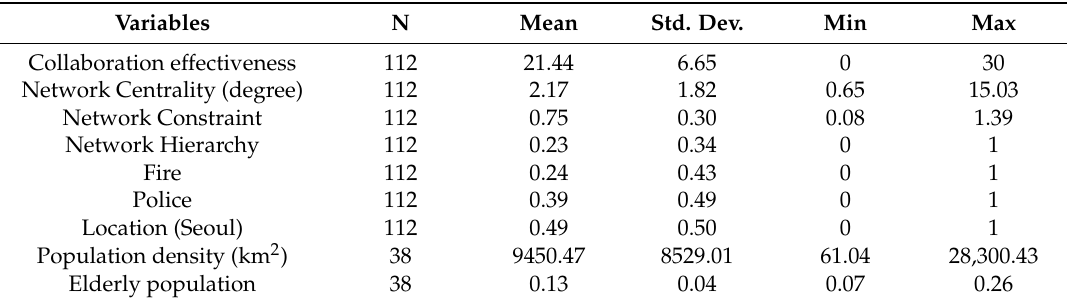
Table 2. Descriptive statistics.